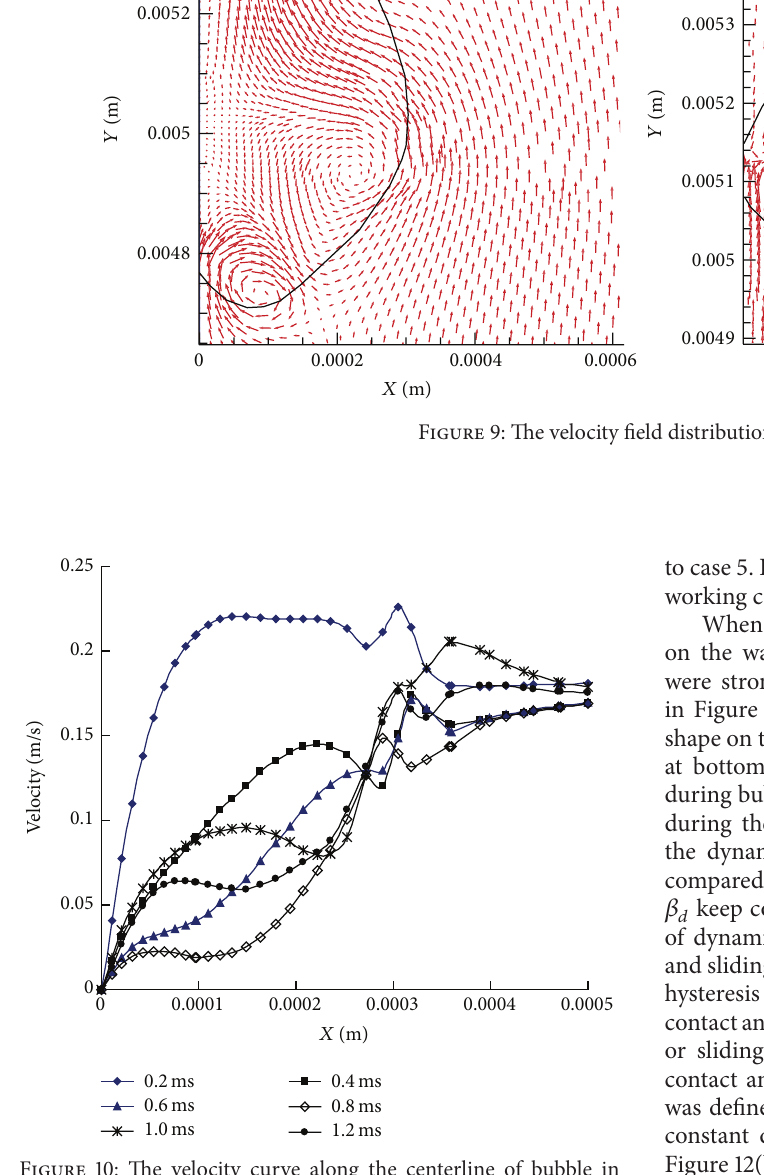
Figure 10: The velocity curve along the centerline of bubble in bubble growth on case 1